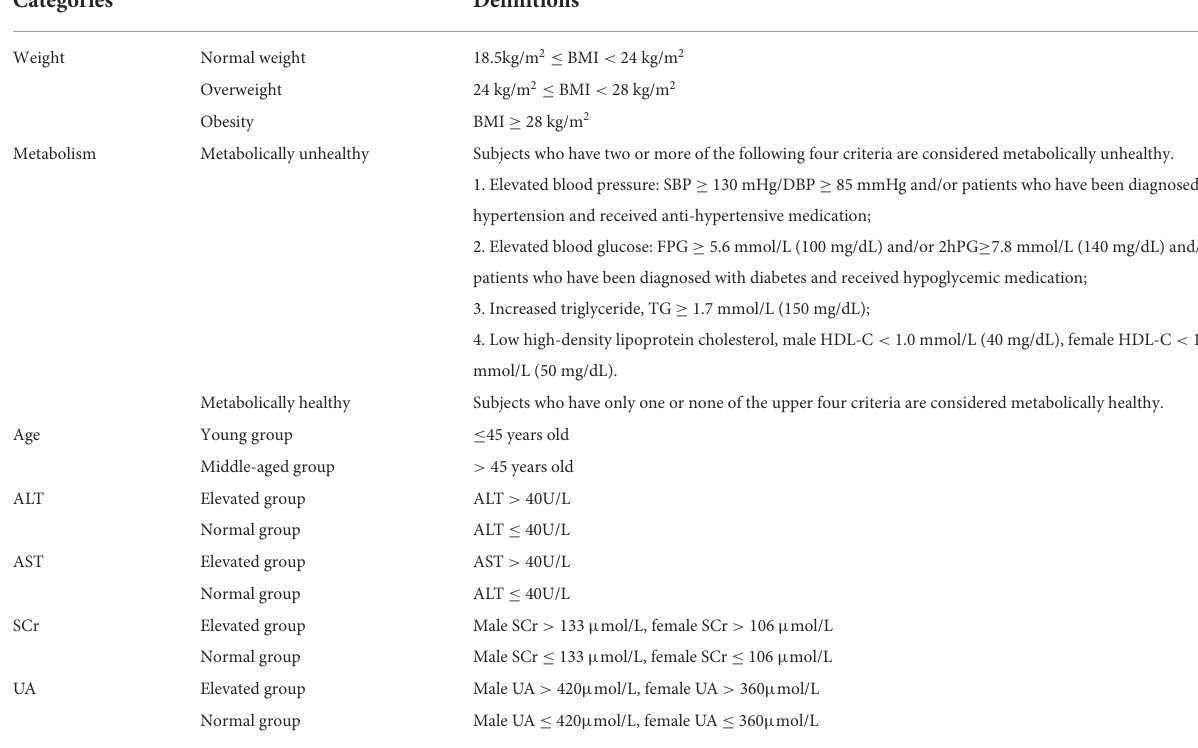
TABLE 1 Definitions of the categories of weight, metabolism, age, ALT, AST, SCr and